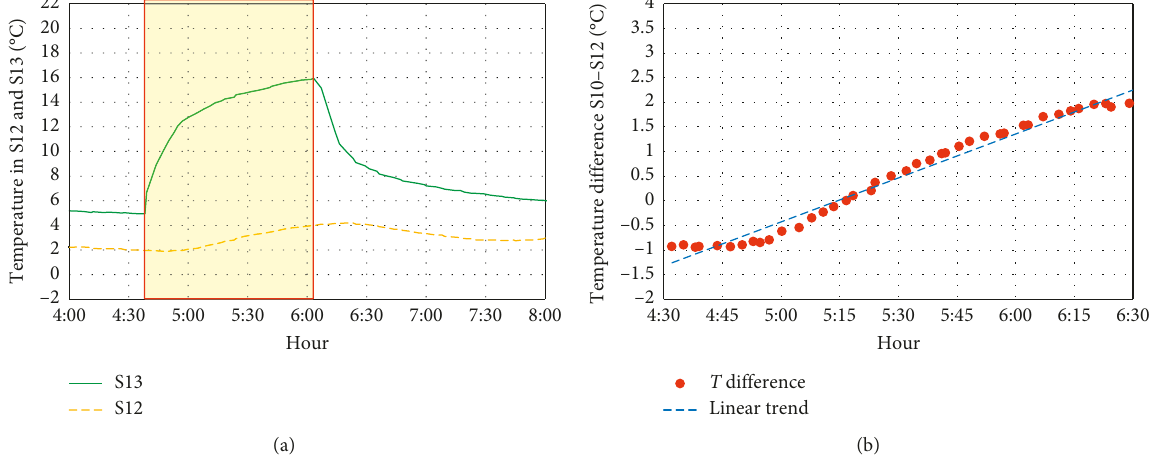
Figure 10: (a) S12 (surface) and (b) S13 (ribbon) temperatures and temperature difference recorded on the surface between R6 and